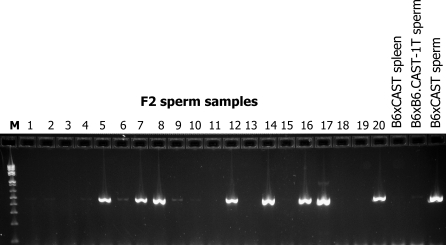
Allele-Specific PCR for Hotspot Hlx1
Gel electrophoresis of F2 samples from the interstrain cross after two rounds of allele-specific PCR. M is a 100-bp ladder; 1–20 are F2 samples; the last three lanes contain negative and positive controls as described.